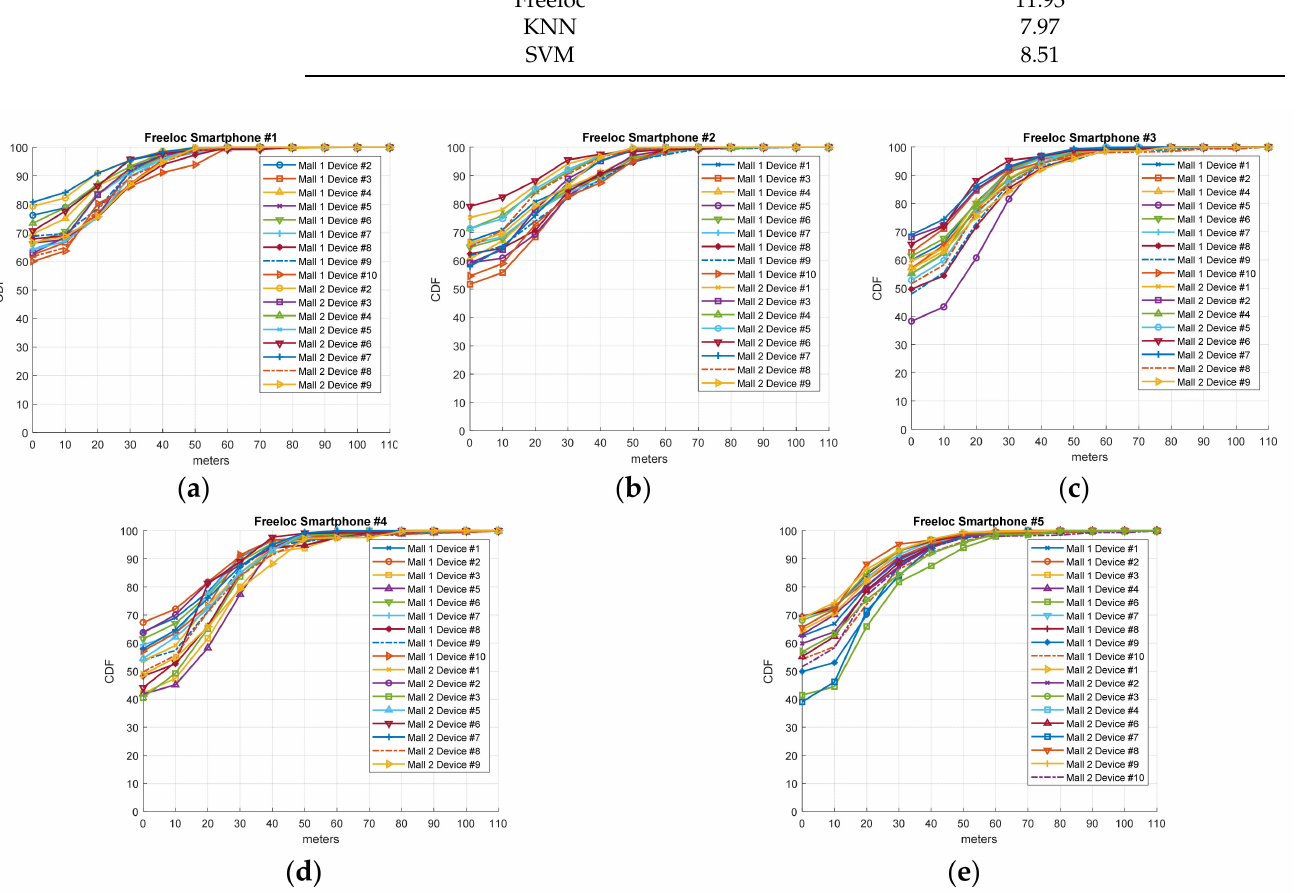
Figure 7. CDF referring to the accuracy of the IPS generated with Freeloc on day 74 for mall #1 and day 60 for mall #2 employing smartphones ( a ) #1, ( b ) #2, ( c ) #3, ( d ) #4, and ( e )